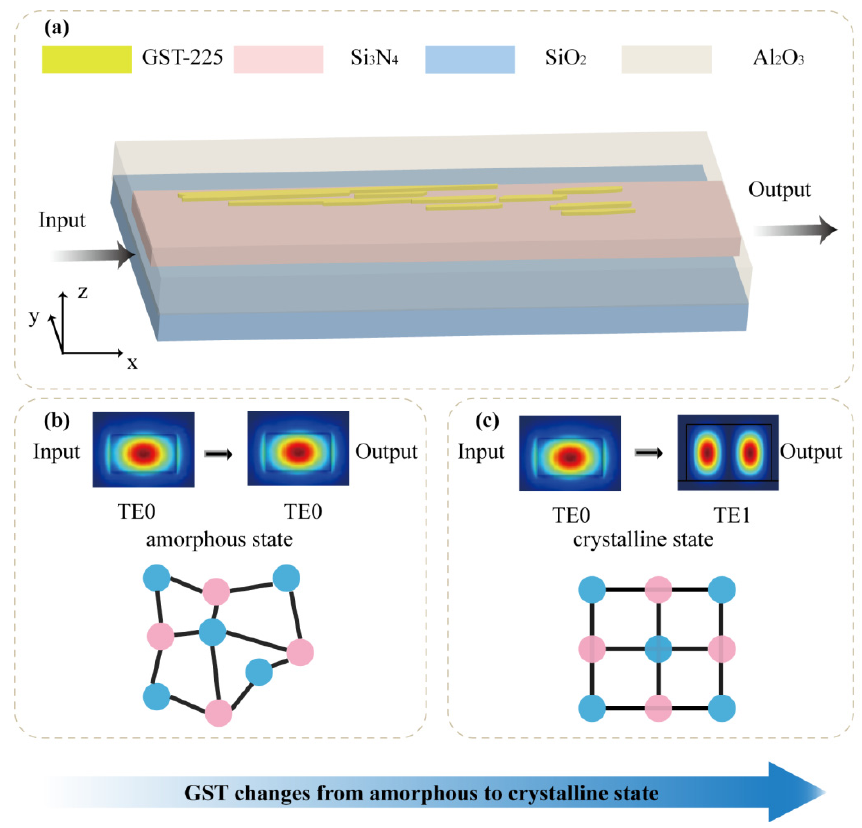
Figure 1. The principles of guided wave-driven metasurfaces. ( a ) The schematic of the programmable mode converter. Inset: cross-section view of the mode converter. ( b ) The electric field distribution on input and output port, when GST-225 is in the amorphous state. ( c ) The electric field distribution on input and output port, when GST-225 is in the crystalline